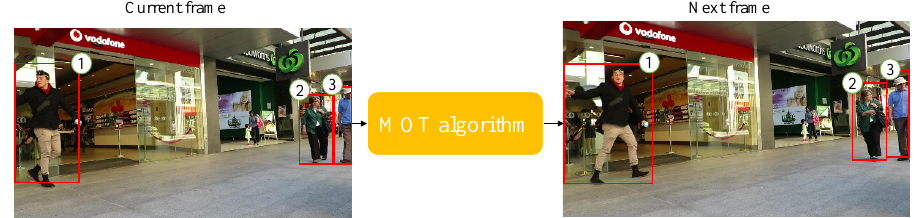
Figure 2. The visualization of the object tracking for the next frame using the MOT algorithm on the MOT15 benchmark dataset [8]. Objects in the following frame are first detected. The detected result is then fed into the MOT algorithm to compare the objects from the current frame with the objects from the next frame. Finally, the IDs are assigned for each object in the next frame based on the current